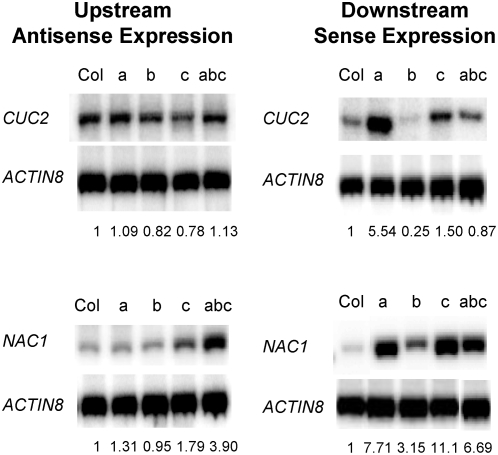
qRT-PCR for selected miRNA targets in different mir164 knockout mutants.
CUC2/AT5G53950 and NAC1/AT1G56010 sense and antisense transcript expression was analyzed in the RNA extracted from the aerial parts of whole plants of the following genotypes: Col: wild type Columbia-0; a: mir164a-4; b: mir164b-1; c: mir164c-2; abc: mir164a-4 b-1 c-1
[35]. See Figure 7 for details of legends.